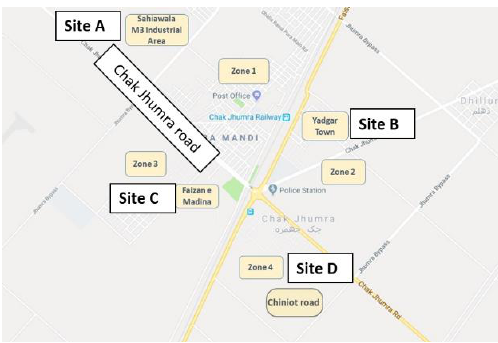
Figure 1: Map of study area at Chak